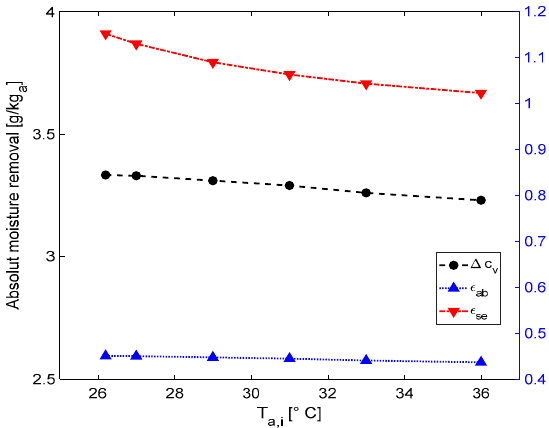
Figure 9. E ff ects of the temperature of the inlet air on the absolute moisture removal, absorption, and sensible e ff ectiveness parameters.